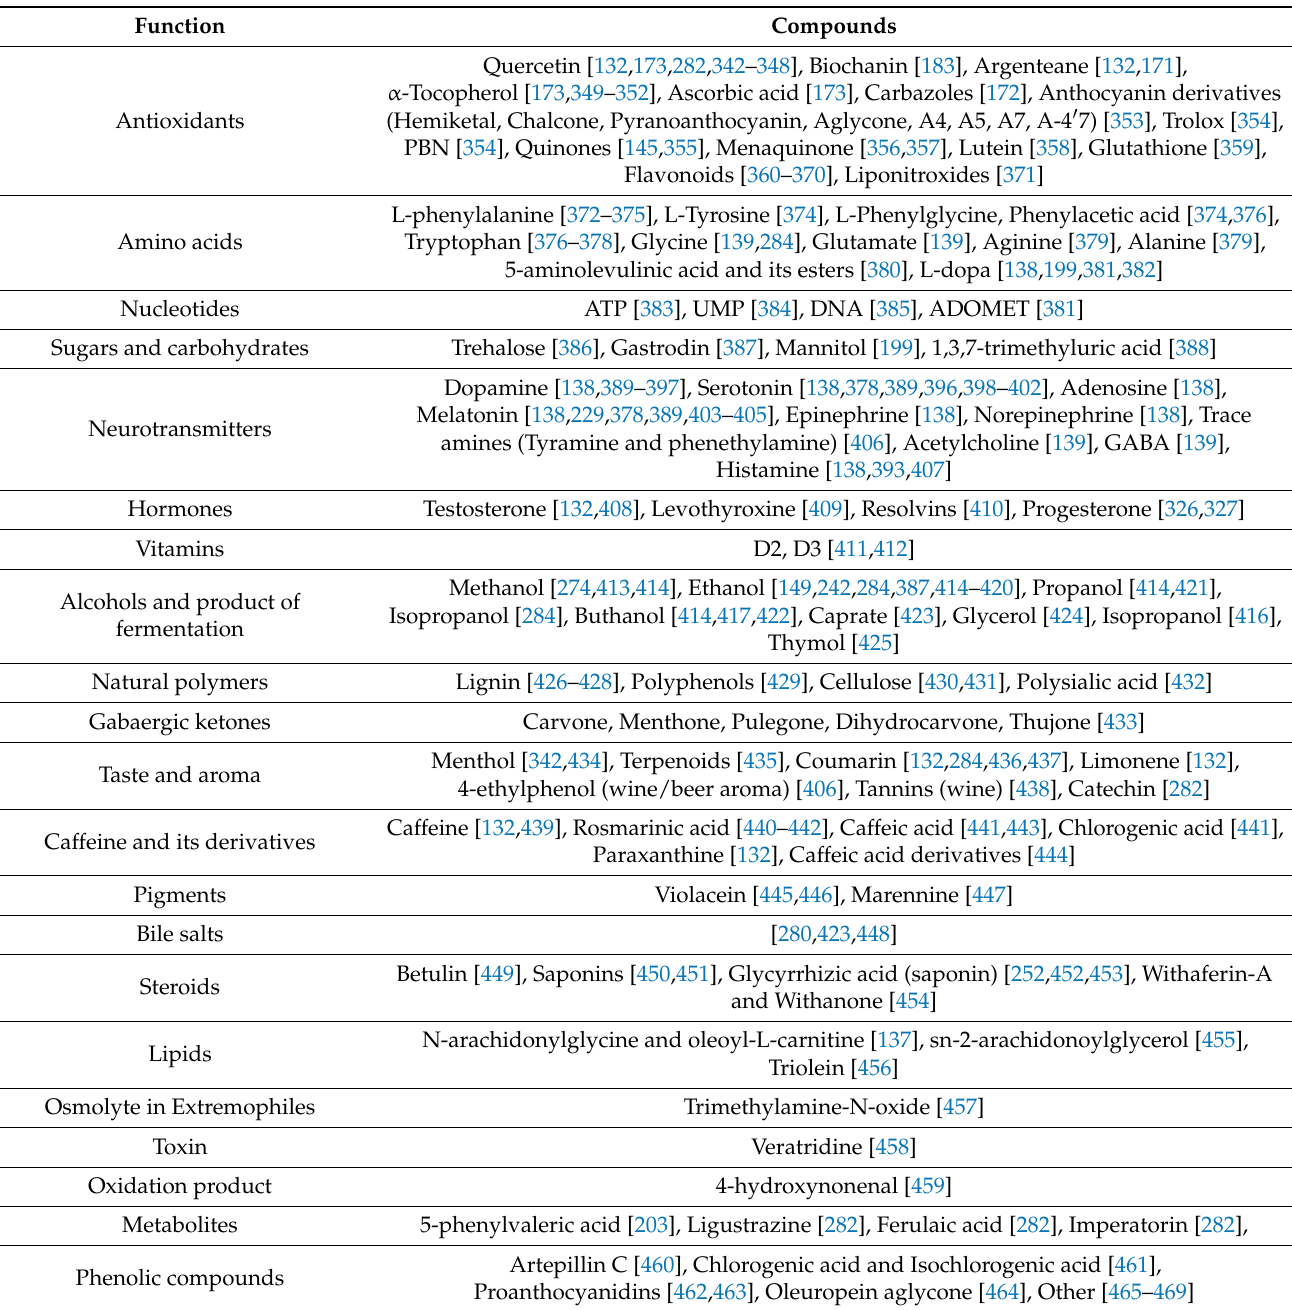
Table 2. List of recent studies of natural compound–membrane